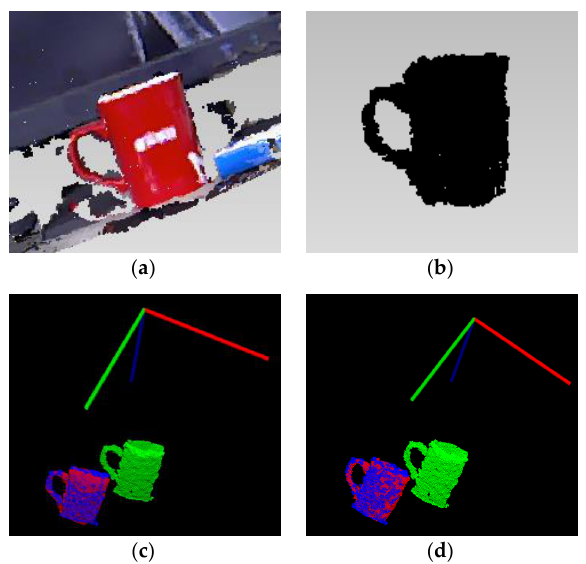
Figure 3. ( a ) Original point cloud; ( b ) Processed point cloud; ( c ) Traditional algorithm; and ( d ) Proposed algorithm.